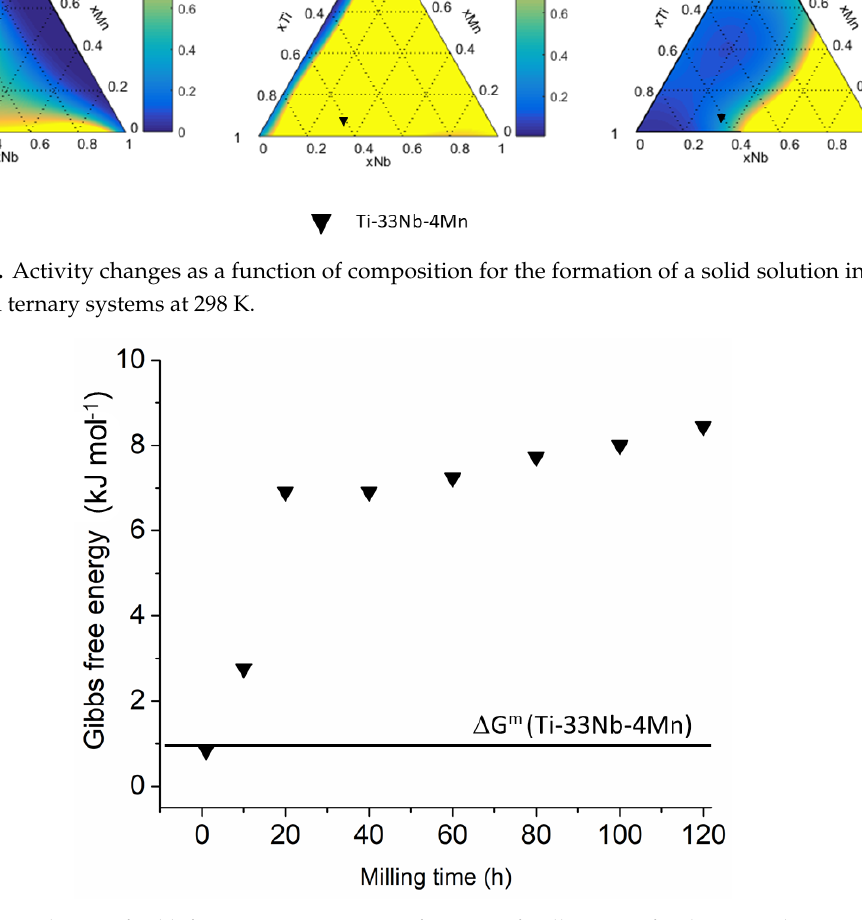
Figure 12. Evolution of Gibb free energy storage as a function of milling time for the Ti ‐ 33Nb ‐ 4Mn alloy.